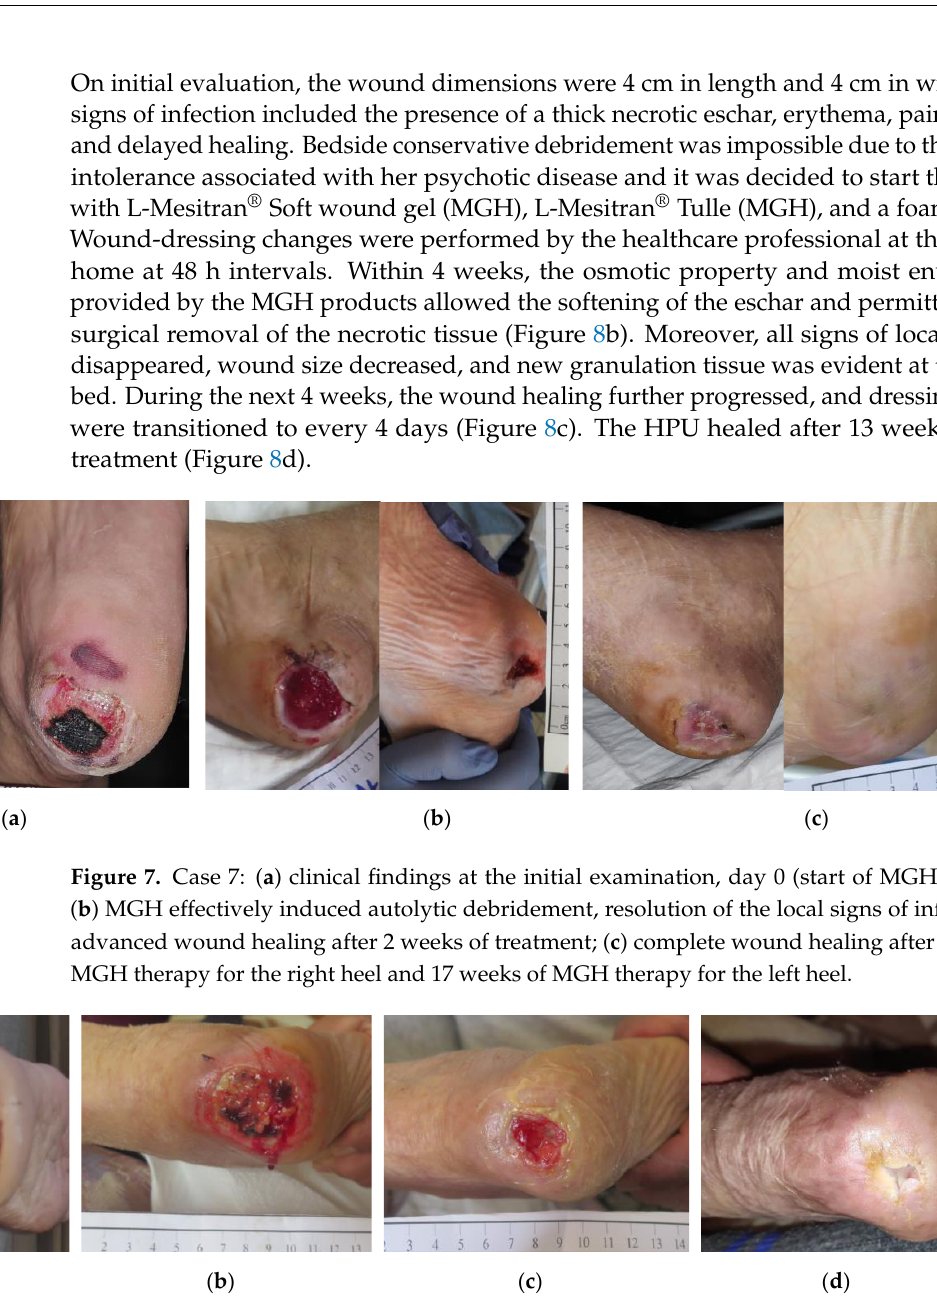
Figure 8. Case 8: ( a ) clinical findings at initial examination, day 0 (start of MGH treatment); ( b ) the MGH products allowed the softening of the eschar and permitted an easy surgical removal of the necrotic tissue with concomitant advanced wound healing after 4 weeks of treatment; ( c ) elimination of local signs of infection and further wound healing progression after 8 weeks of MGH therapy; ( d ) complete wound healing after 13 weeks of MGH